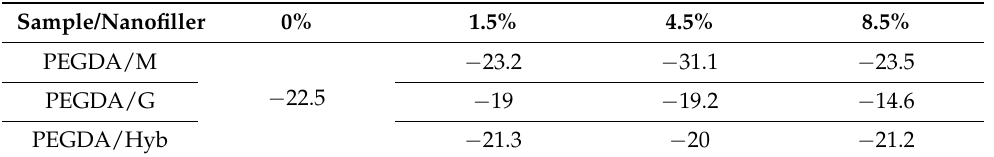
Table 2. T g ( ◦ C) of neat PEGDA, and composites PEGDA/G, PEGDA/M and PEGDA/Hyb at different percentage of nanofillers obtained by DSC.